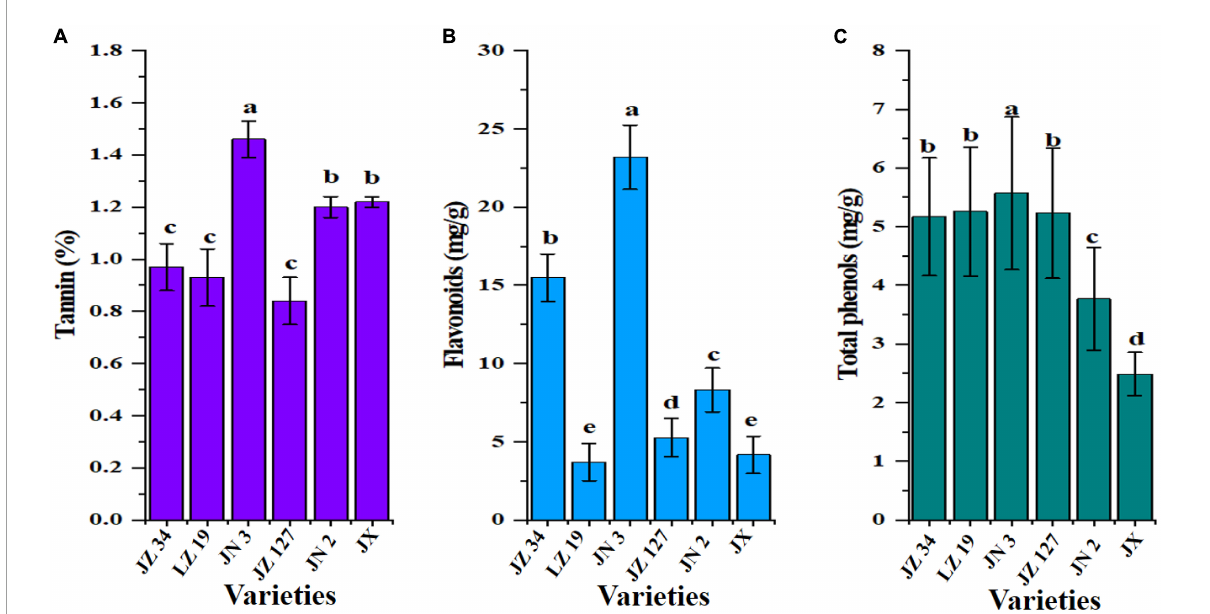
Data are representedas the mean ± SD of triplicatedeterminations. Along the same row, valueshaving different letter vary significantlydifferent ( p < 0.05). JZ 34,jinza 34; LZ 19, liaoza 19;JN3,jinnuo3;JZ127,jiza127;JN2,jiniang2;JX,jiaxian.